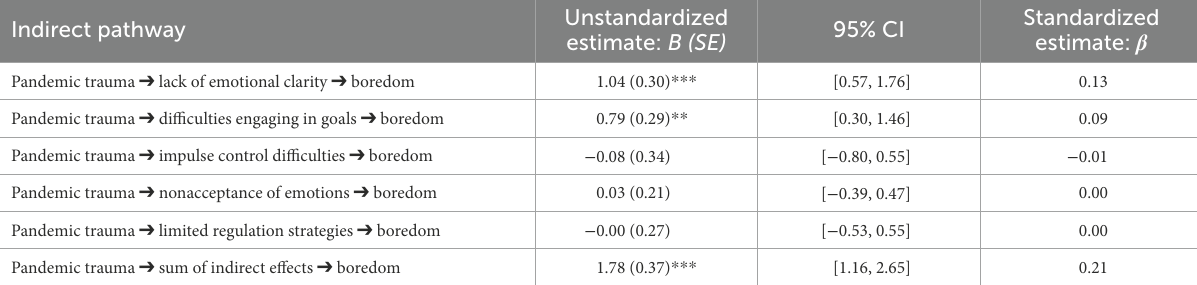
TABLE 4 Unstandardized and standardized estimates and confidence intervals for indirect pathways to boredom ( N = 344). Indirect